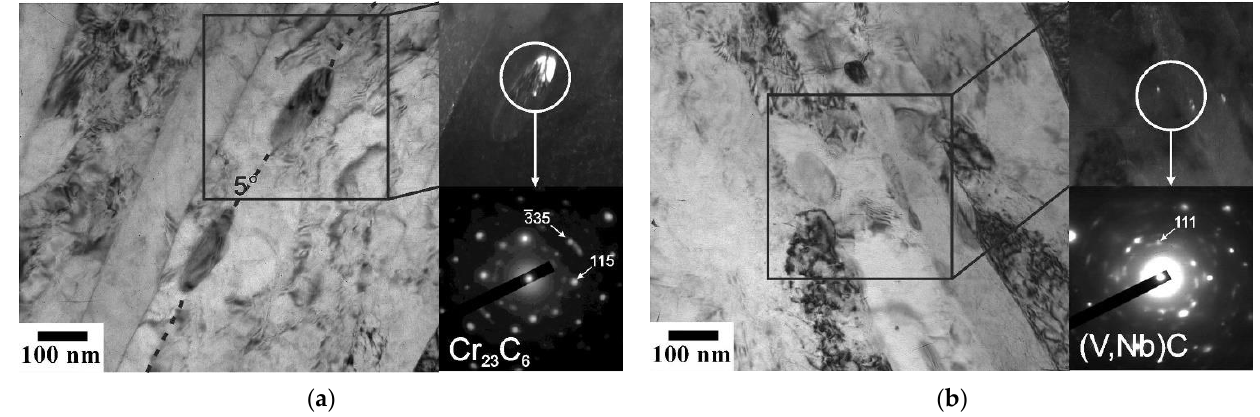
Figure 2. Dispersed carbides in an HSLA steel subjected to tempforming at 873 K.